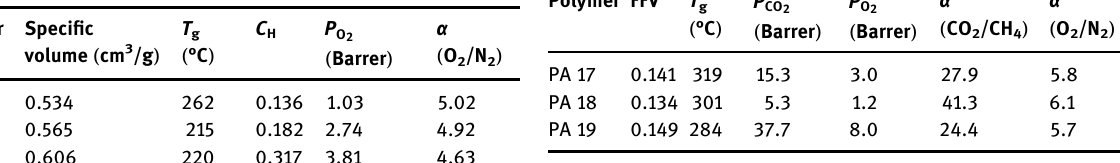
Polymer Speci fi